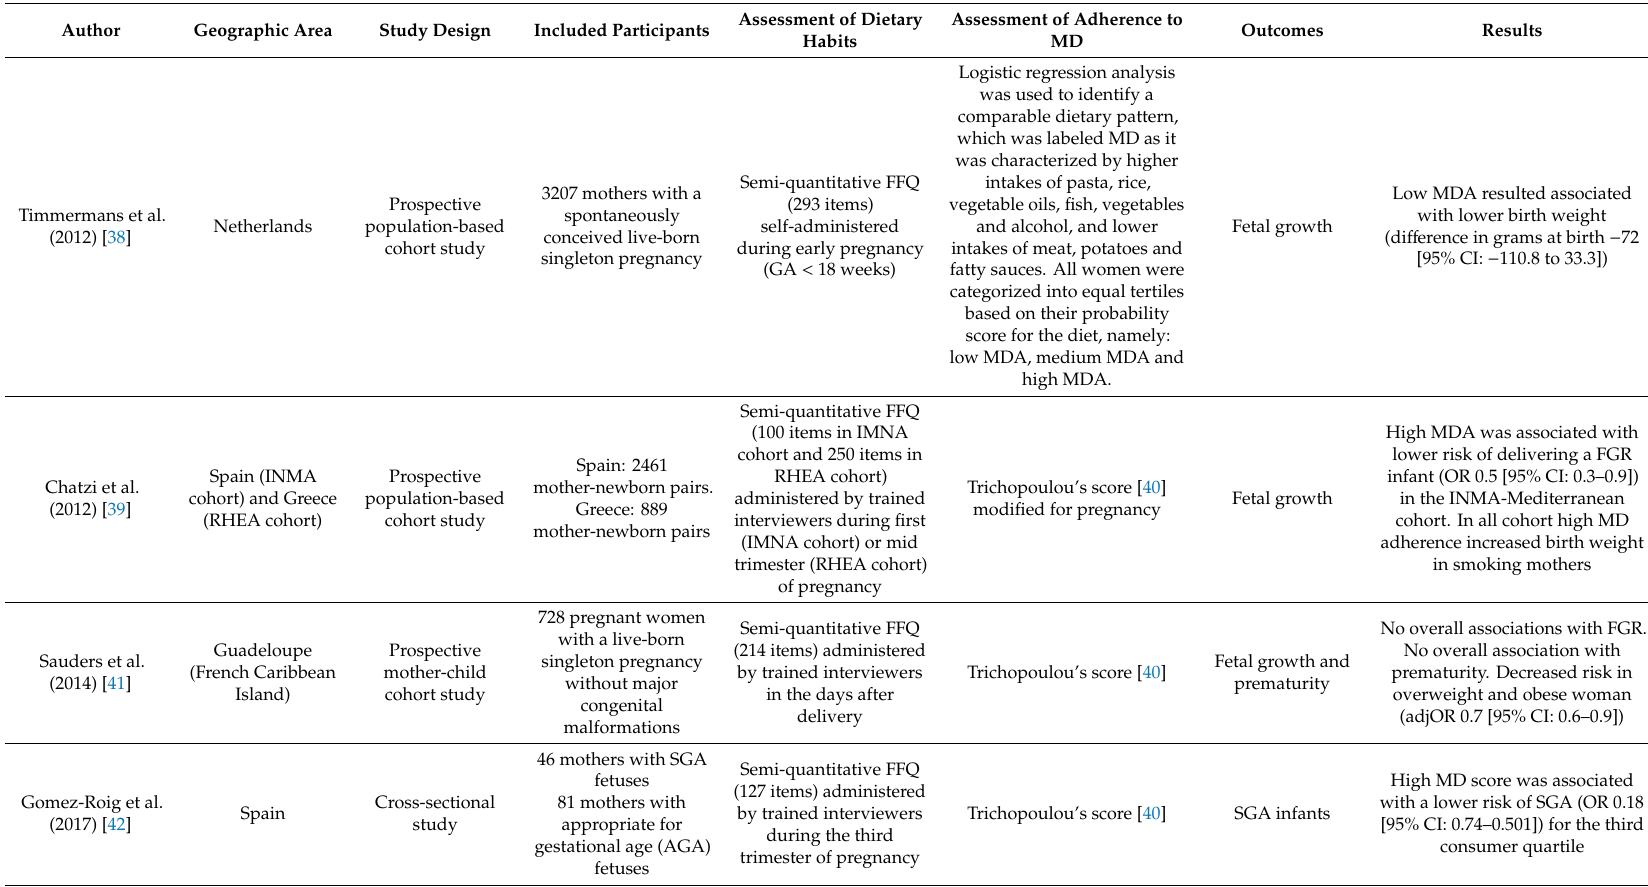
Table 1. Summary of the included